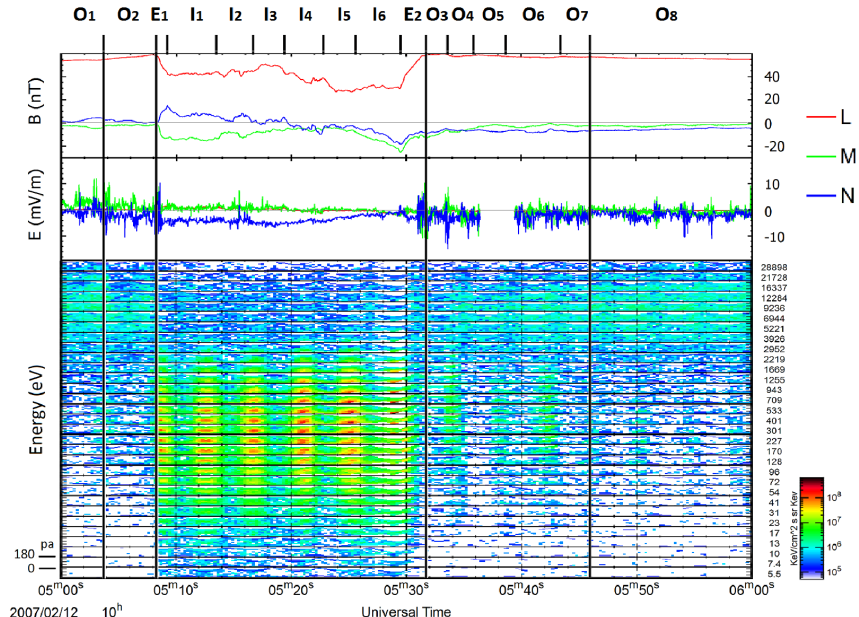
Figure 7. High-time-resolution ion observations from Cluster 1 between 10:05 and 10:06UT. During this time interval, significant fluxes of high-energy ions were observed above ∼ 4keV in regions O 1 and O 8 . The ion populations observed in the regions immediately surrounding the structure (in particular the regions labelled O 2 , and also O 3 –O 7 ) contained significant fluxes of ions in both the high-energy (similar to those observed in O 1 and O 8 ) and a lower-energy (between ∼ 50eV and 2keV) bands. From the beginning of region E 1 until the end of region E 2 , the flux of high-energy ions of magnetospheric origin drops, and the main population is centred at low energy between ∼ 50eV and 2keV. We note that the population with lower energy shows some modulation of flux at close to the spin frequency (4.148s) in regions E 1 to O 7 . This is a result of the ions with magnetosheath energies not being gyrotropic, and thus the flux of incoming ions increases every time the HIA instrument looks into the flow direction. Inside the structure, there are six points in time at which a representative pitch angle distribution of ions is obtainable. (See Sect.4.4.2 and Fig. 8 for